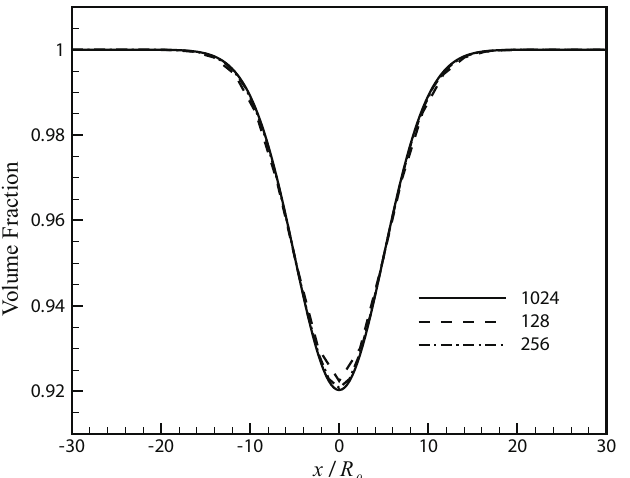
Figure 5. Single bubble oscillating: Volume fraction α l along the bubble radius for different resolutions.